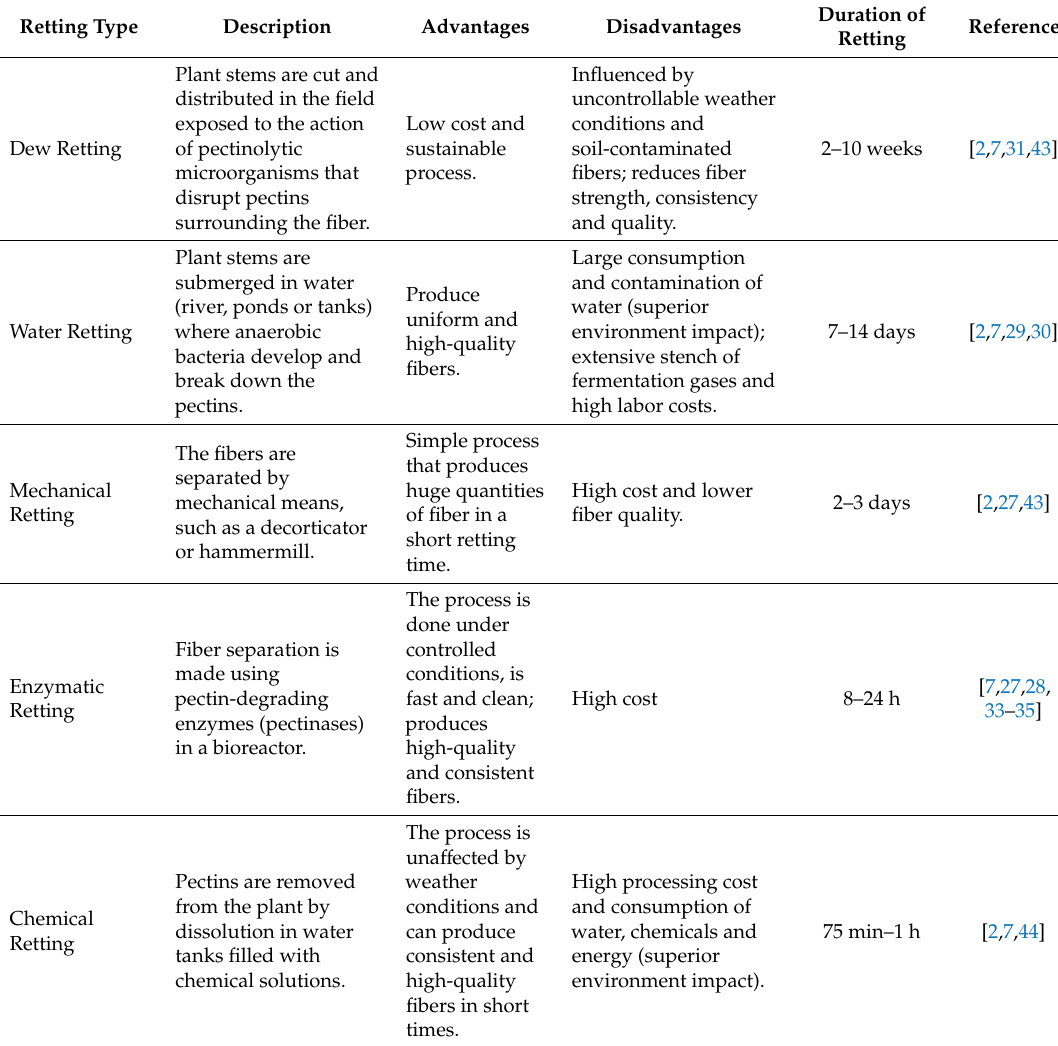
Table 2. Properties and limitations of the five types of retting